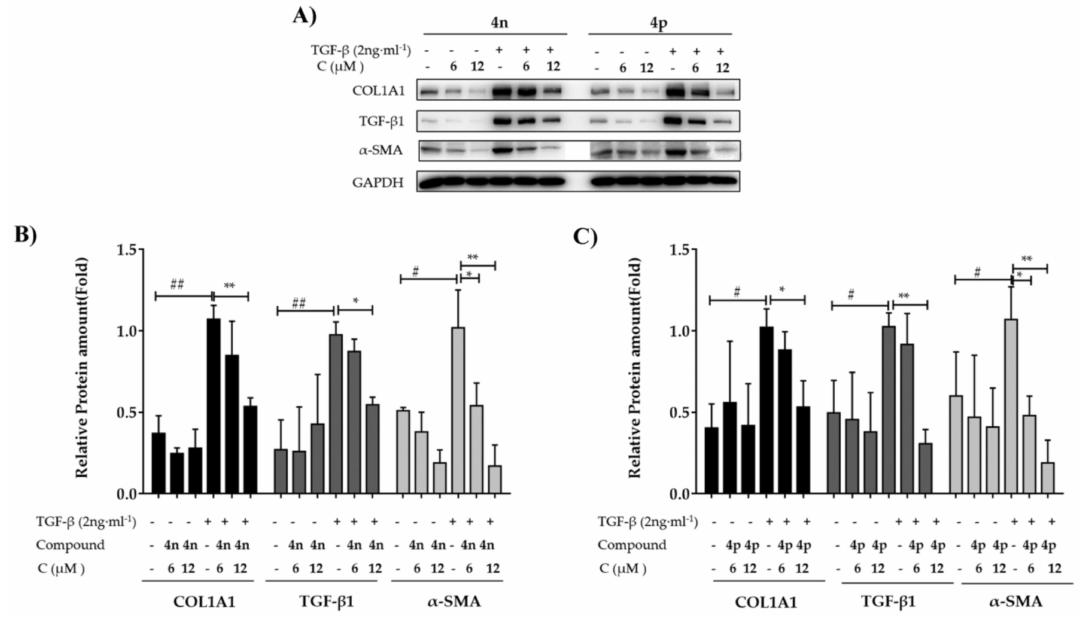
Figure 3. ( A ) E ff ects of compounds 4n and 4p on inhibiting fibrogenic COL1A1, TGF- β and α -SMA on protein level in LX-2 cells by western blot assay after a 24 h treatment. ( B ) Gray scanning analysis of 4n on inhibiting fibrogenic COL1A1, TGF- β and α -SMA on protein level. ( C ) Gray scanning analysis of 4p on inhibiting fibrogenic COL1A1, TGF- β and α -SMA on protein level. Data were presented as the mean ± SEM, (#) p < 0.05, (##) p < 0.01 as compared to that of control group; (*) p < 0.05, (**) p < 0.01 as compared to that of TGF- β 1 group. The protein expression levels were normalized against GAPDH. The experiment was repeated three